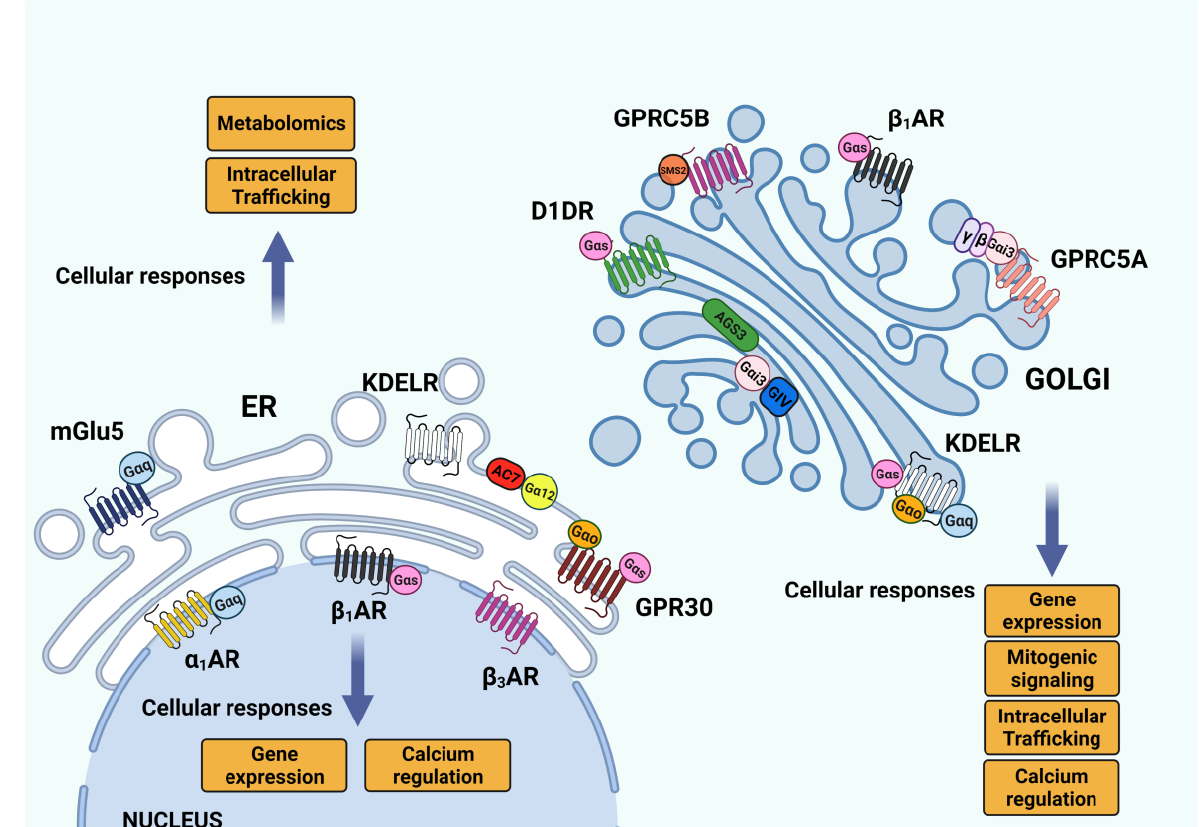
Figure 3. G-proteins and GPCR signaling in the endomembrane system — Golgi, endoplasmic reticulum. of human proteins, but it is also an important reservoir of signaling molecules. So far, heterotrimeric G-proteins and GPCRs have been reported to act only from the plasma membrane, but indeed, many of these signaling molecules have been localized and have a functional role in the endomembrane system. In this picture, we summarized the literature cited in this review regarding G-proteins and GPCRs in the Golgi apparatus, ER and nuclear envelope/nucleus, with the cellular responses also generated from their downstream signaling pathways.